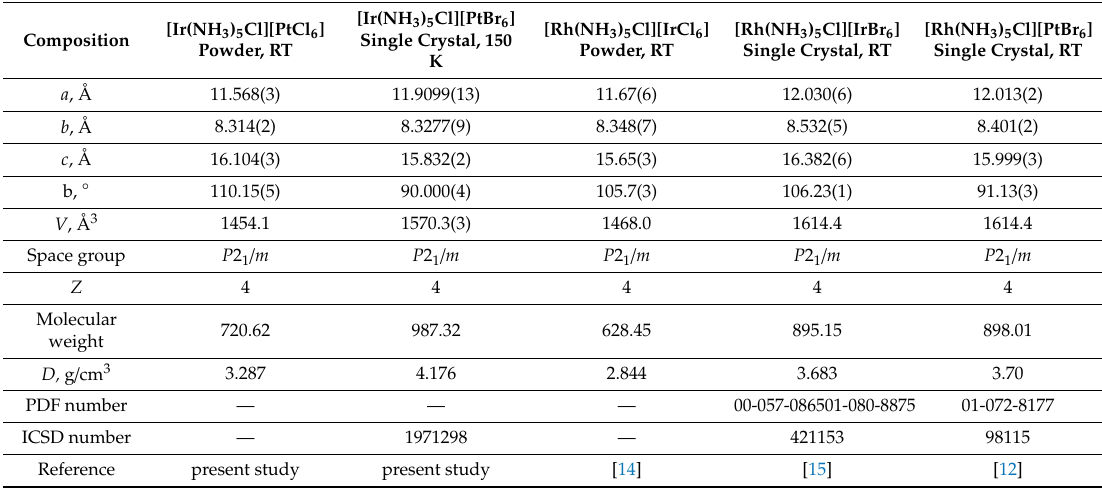
Table 2. Crystallographic characteristics for [ M I (NH 3 ) 5 Cl][ M II Г 6 ] M I = Rh, Ir; M II = Ir, Pt and Г = Cl and Br single-source